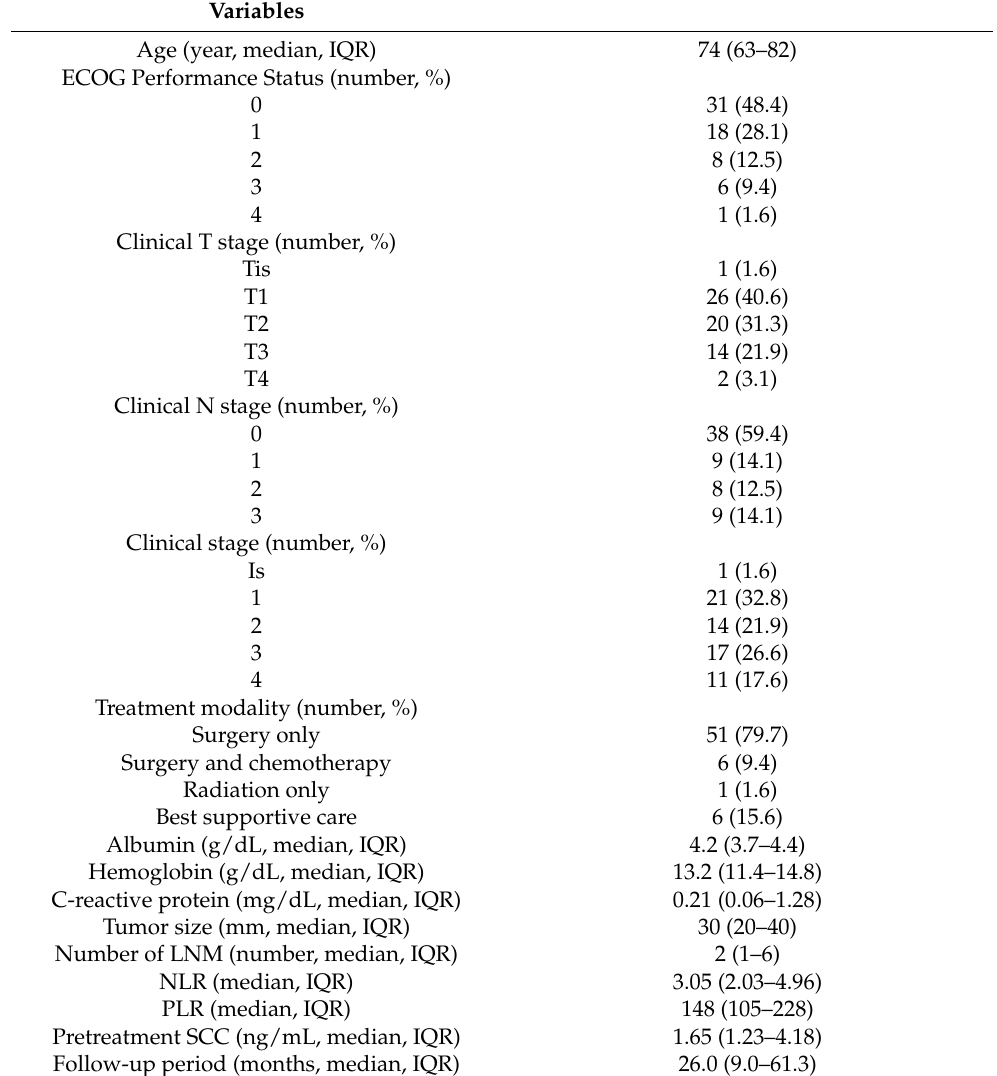
Table 1. Patient